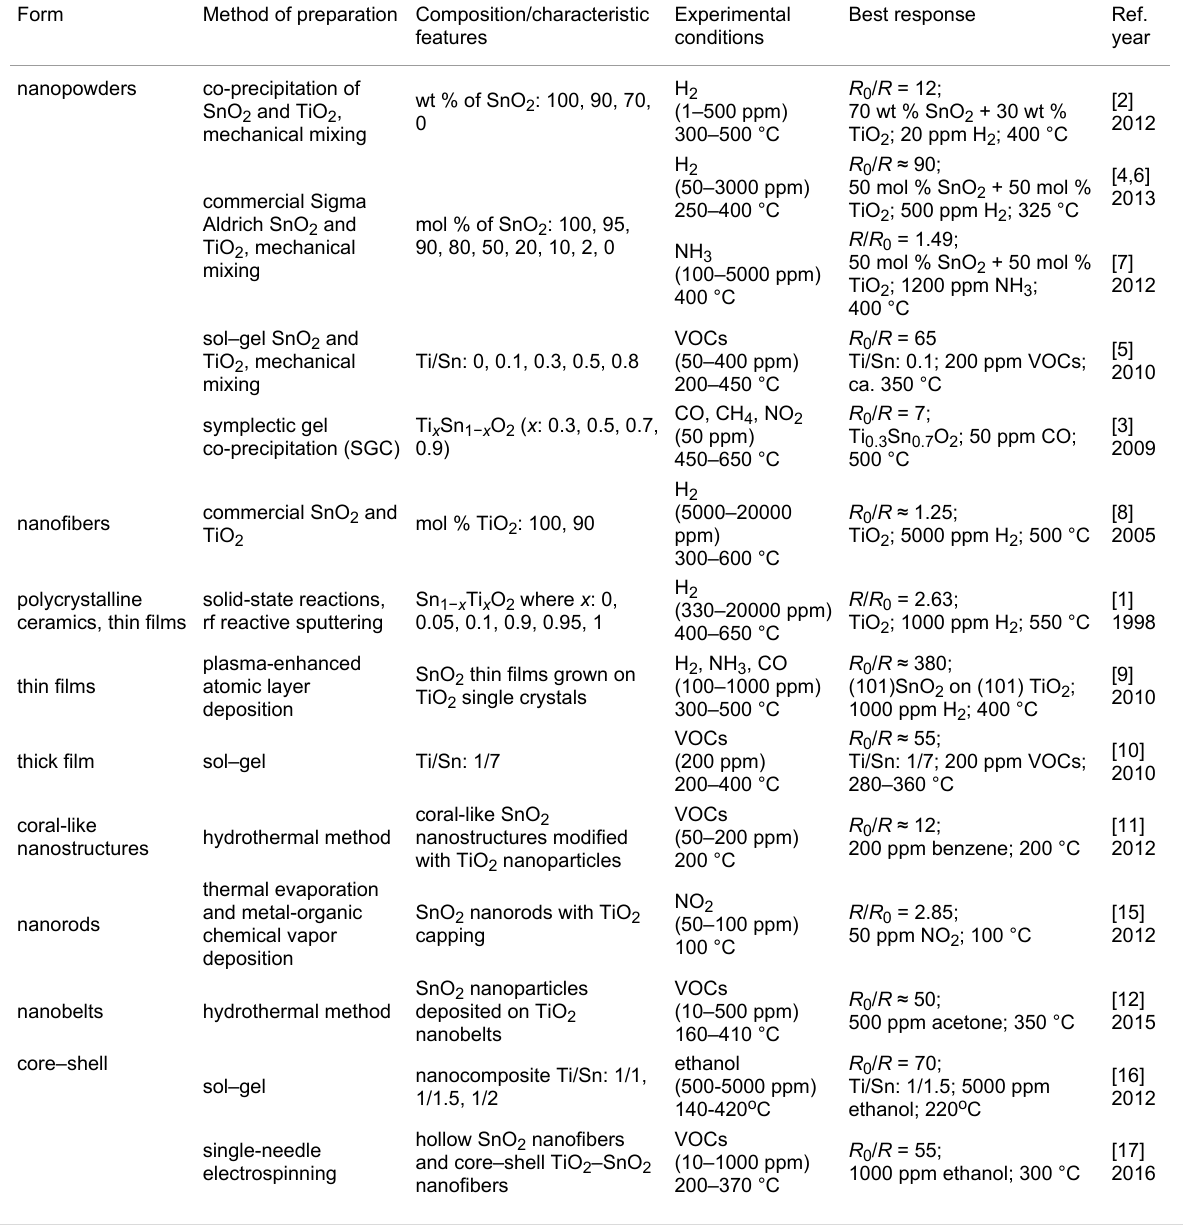
Table 1: TiO 2 –SnO 2 systems for gas sensing. The best response is defined either as: R 0 / R (for n -type material + reducing gas and p -type material + oxidizing gas) or R / R 0 (for n -type material + oxidizing gas and p -type material + reducing gas), where R 0 denotes the electrical resistance in the refer- ence atmosphere and R is the electrical resistance under exposure to the detected gas.